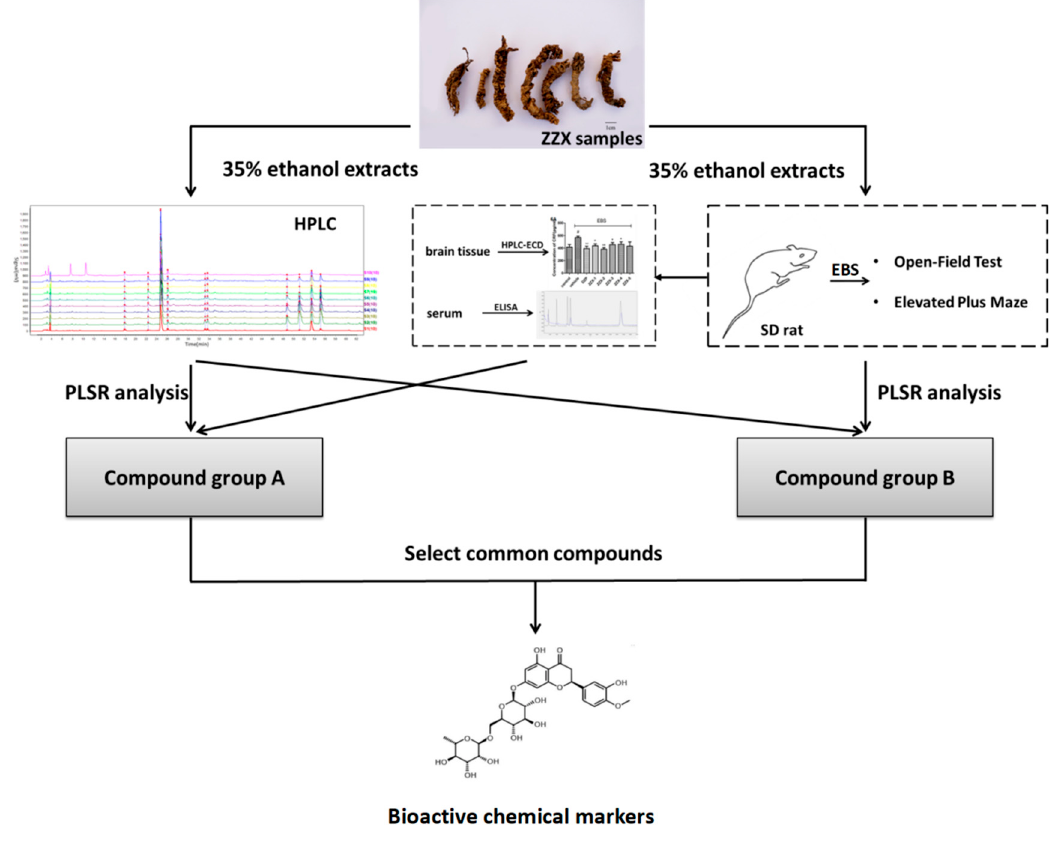
Figure 10. The overall flow chart of the experiment.